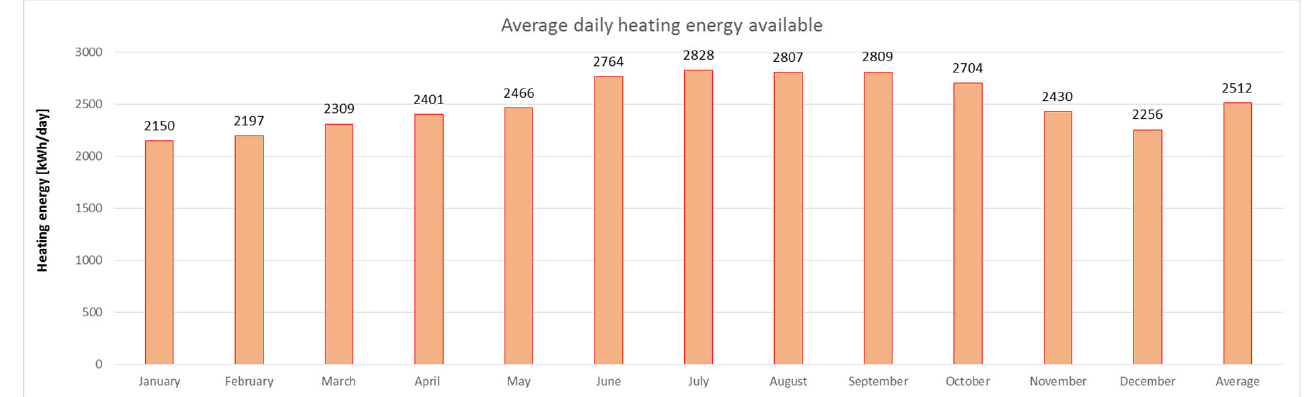
Figure 10. Average heating energy daily available at the plate condenser, expressed in kWh/day.